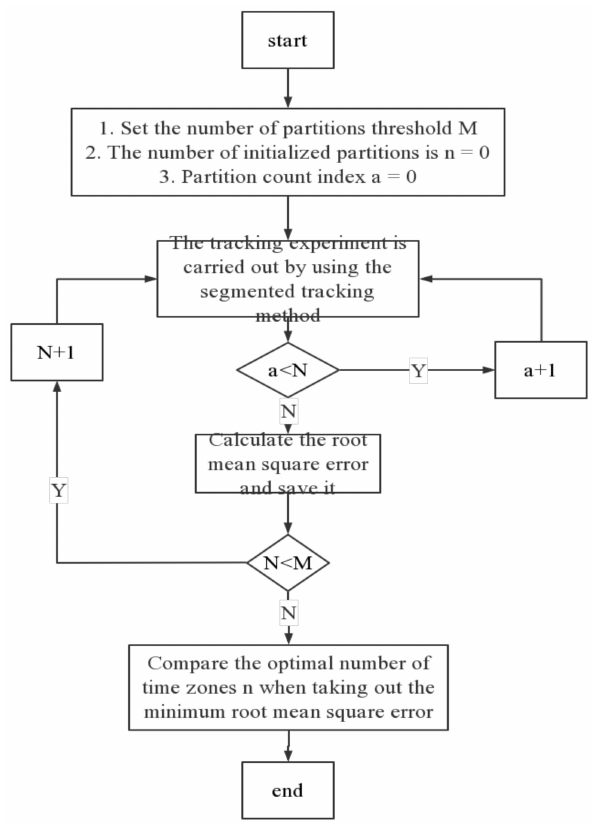
Figure 14. Flow chart of automatic optimization algorithm for the partition number of probes in the